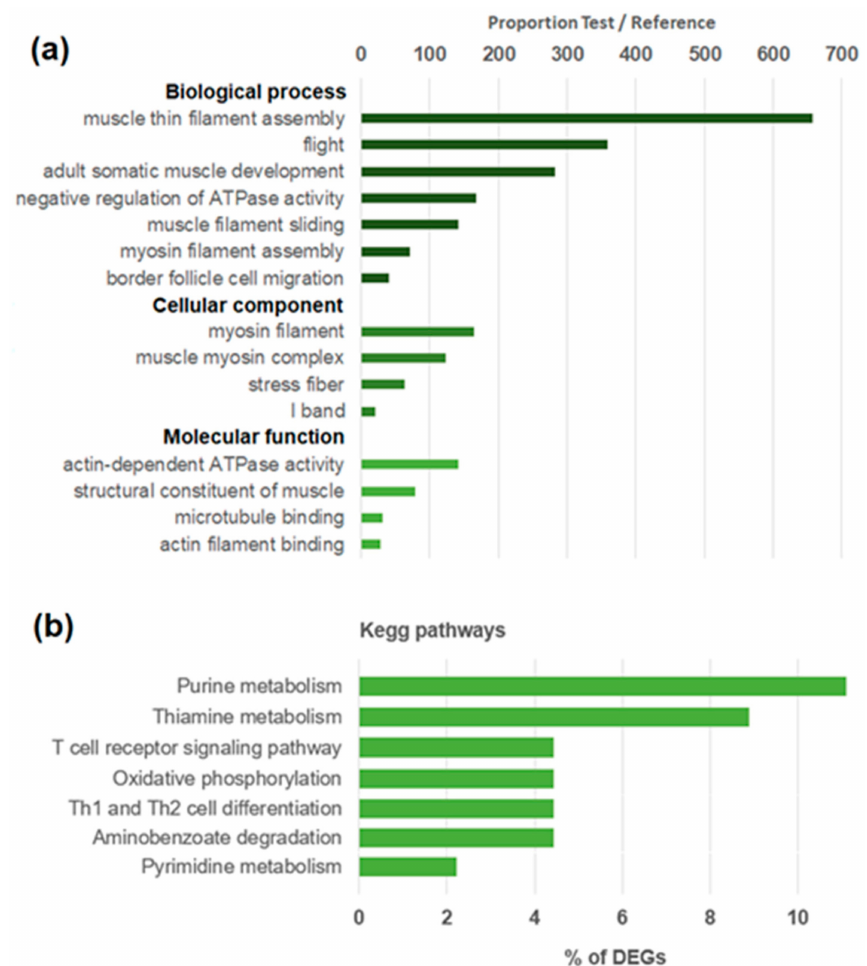
Figure 1. ( a ) Enrichment analysis of di ff erentially expressed genes (DEGs). Bars represent the significant changes of proportion between the percentage of sequences in the DEG list and the transcriptome. ( b ) KEGG (Kyoto Encyclopedia of Genes and Genomes) pathways related to the regulated transcripts after a myticin C treatment. Genes related to O 2 homeostasis (cytochrome c oxidase subunit 1 and cytoglobin) or the regulation of cell physiology under normal and stress conditions ( HSP22 and HSP40 ) are also up-regulated in the myticin C-treated hemocyte